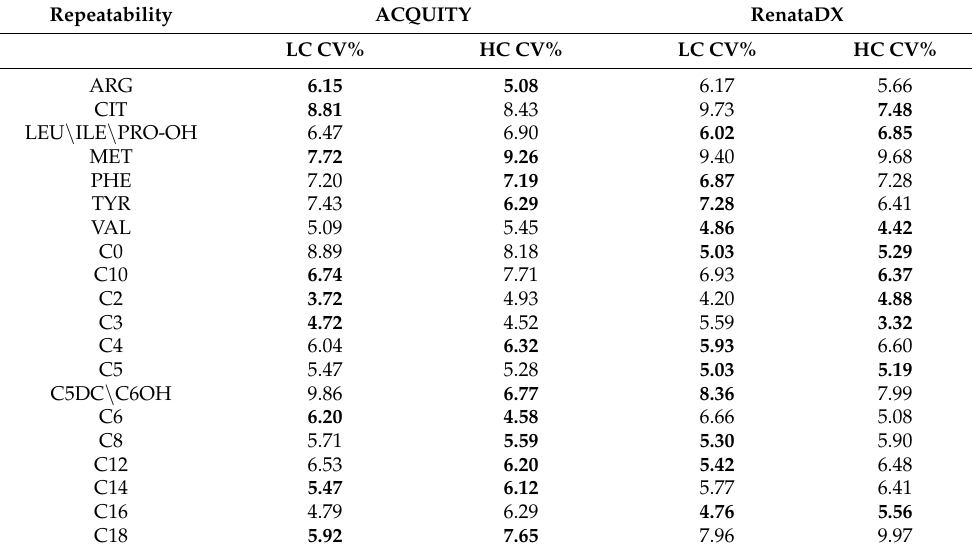
Table 1. Comparison of repeatability values from NeoBase™ 2 Non-derivatized MSMS kit QC levels between ACQUITY UPLC I-Class and RenataDX Screening systems. For each analyte, the lower %CV value was highlighted in bold for both low (LC) and high (HC) QC levels